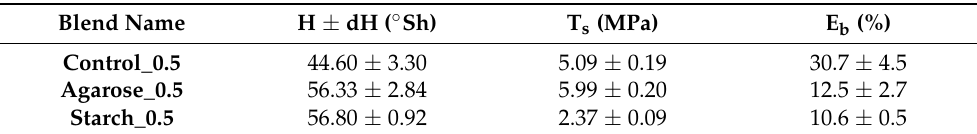
Table 6. Results of mechanical analysis (Shore hardness H; tensile strength T S ; relative elongation at break E b ) of biopolymer blends after thermo-oxidative aging.